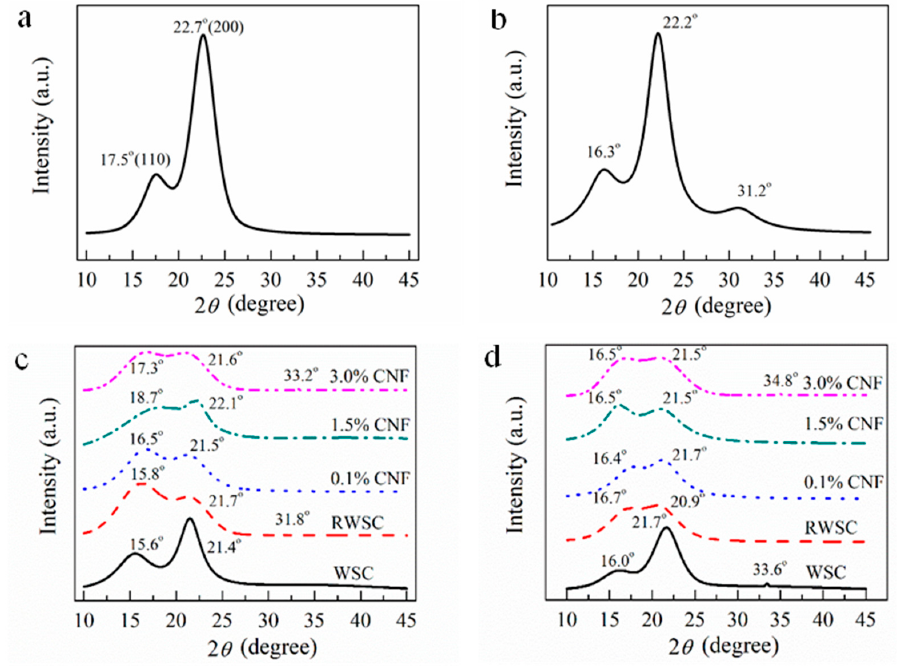
Figure 7. XRD curves of CNFs, WSC, RWSC, and all-cellulose nanocomposites: ( a ) CNFs; ( b ) wheat straw powder; ( c ) WSC prepared by AM; ( d ) WSC prepared by EM.